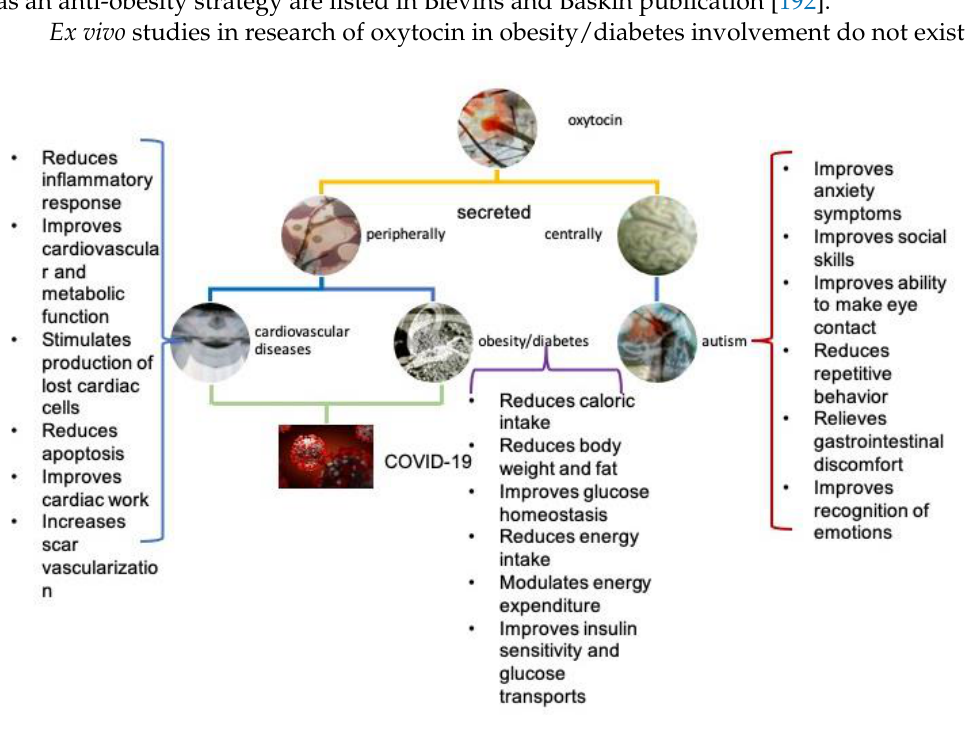
Figure 2. Diagram showing the diseases discussed in this manuscript which might be affected by the use of oxytocin. The key role of oxytocin is mentioned in each situation. The photographs (except the one of COVID19) are from the video Tender Morality , by Stavros Panagiotakis. Table 2. List of the studies ( in vitro , in vivo , ex vivo and human) presented in Table 1 with related result of oxytocin intervention and/or treatment of degenerative diseases.